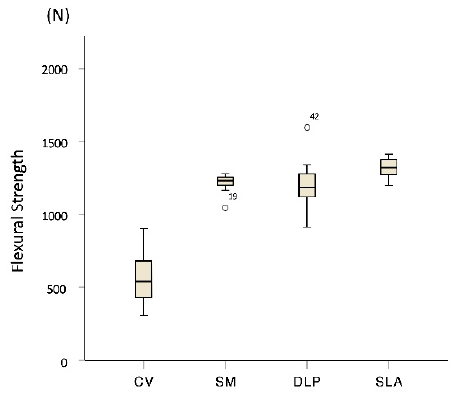
Figure 4. Flexural strength of each group. Different lowercase letters indicate statistical difference among groups (multiple comparison by Mann–Whitney U test with Bonferroni) ( p < 0.05).